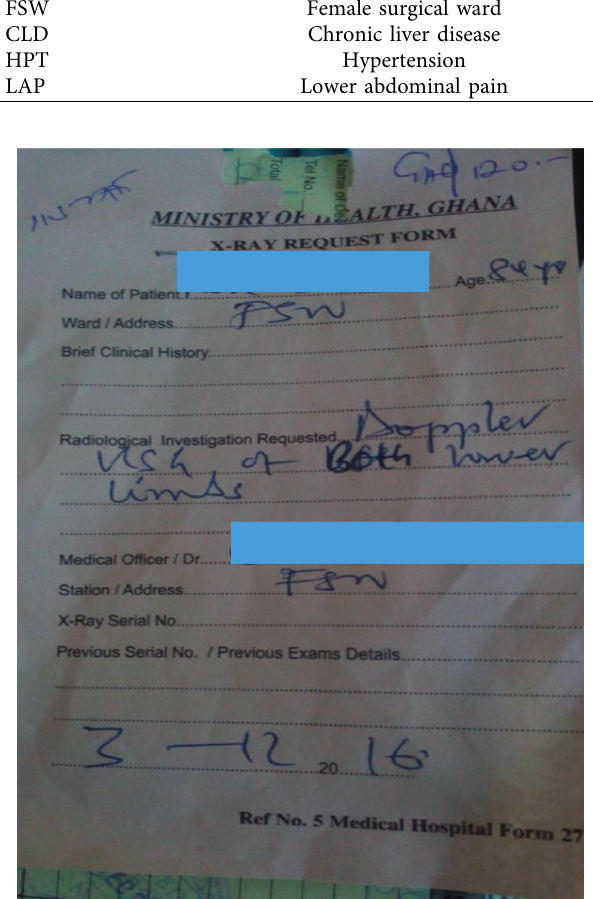
Figure 4: A sample of a request form. No clinical history is provided. The investigation requested is not specific as it has cost implications to the patient. The X-ray serial number and previous examination details were not provided. Unknown medical ab- breviation is noted at ward/address.